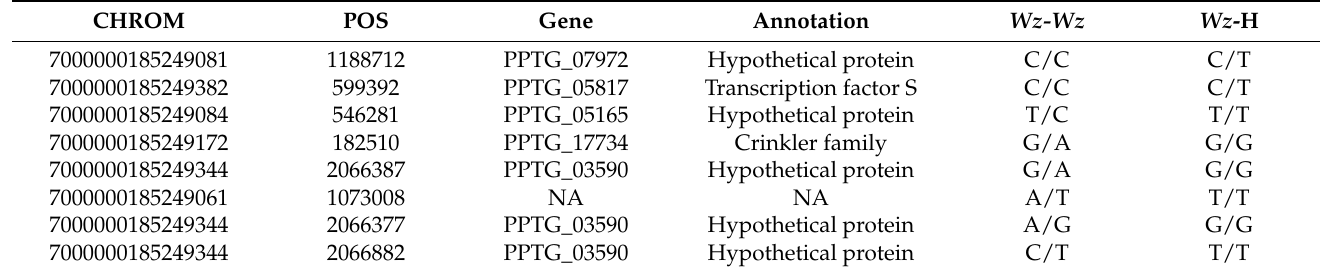
Table 6. SNPs identified in thte Wz-Wz and Wz -H isolates of P. nicotianae .